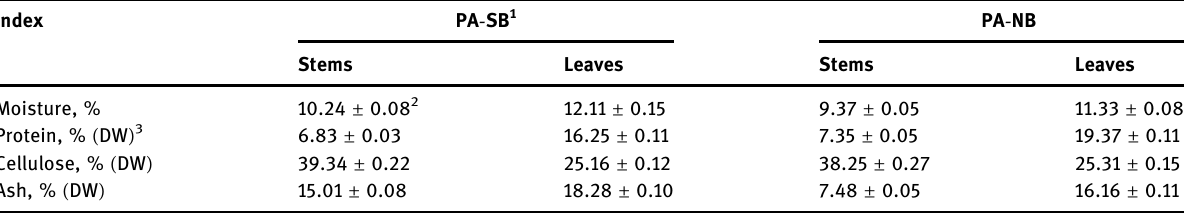
Table 1: Principle chemical indices of P. alkekengi leaves and stems Index